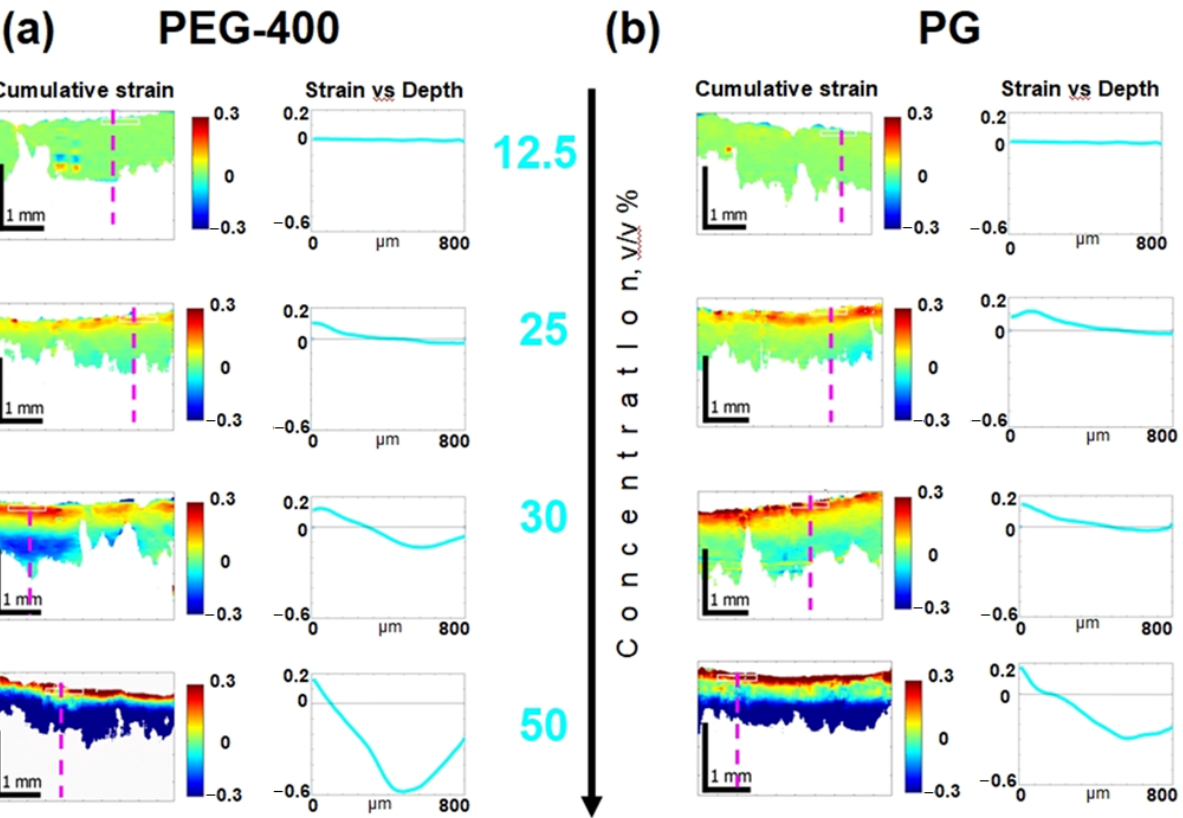
Figure 6. Evolution of strain in cartilage induced by various concentrations of ( a ) PEG-400 and ( b ) PG. Visualized distributions of cumulative strains attained by the end of 600 s intervals together with the in-depth profiles along the dashed lines in the 2D images are shown for PEG-400 and PG solutions with concentrations of 12.5, 25, 30 and 50% ( v / v ).